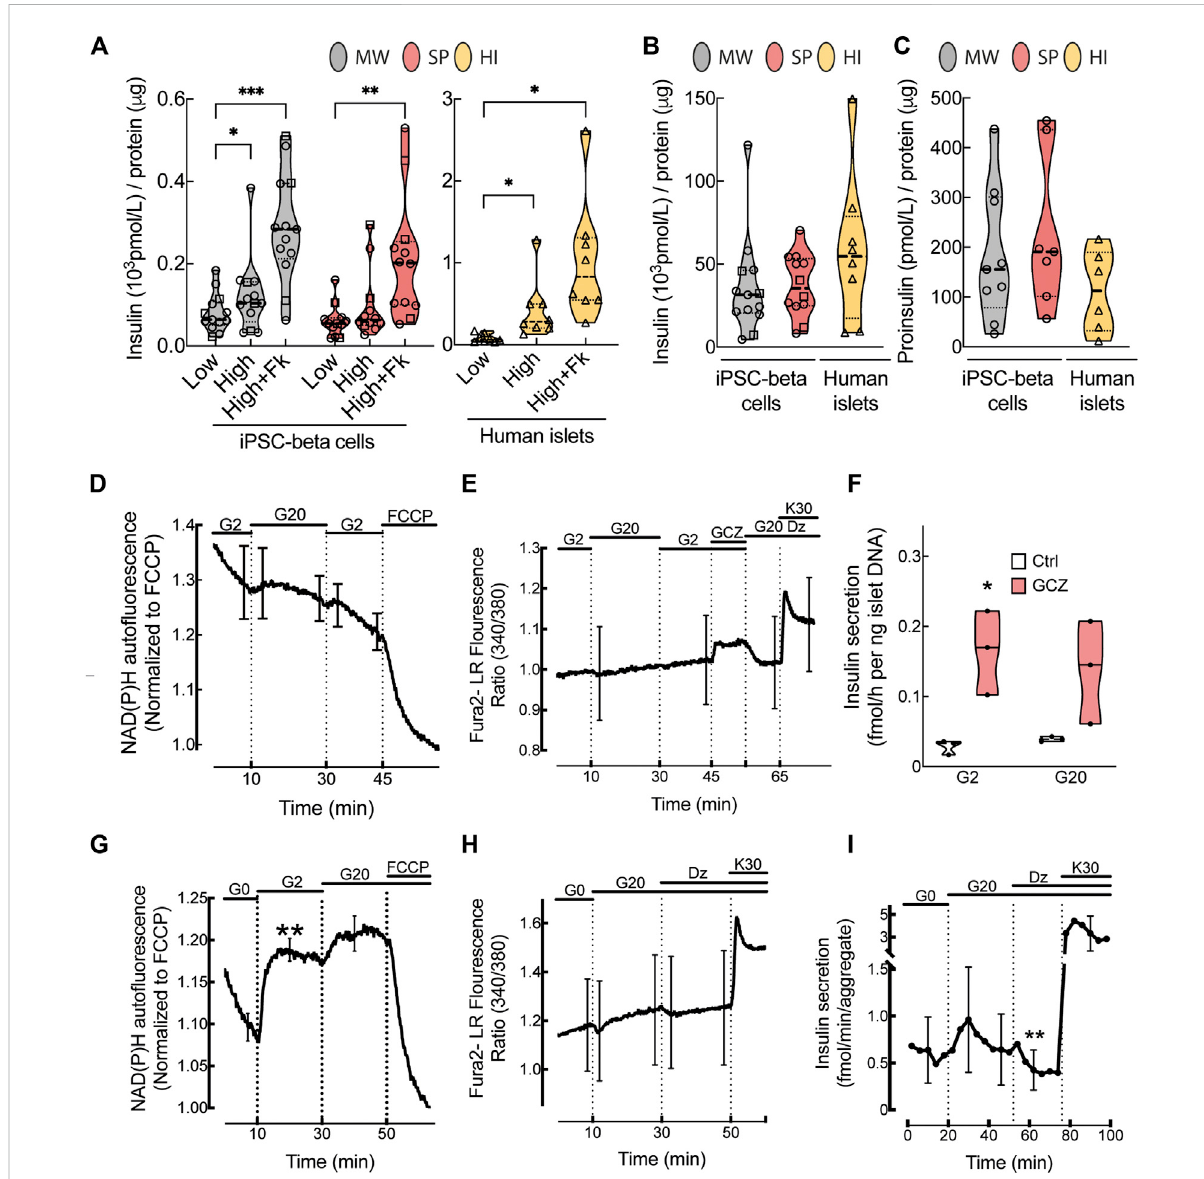
FIGURE 3 In vitro function of human iPSC-derived beta cells. (A) , Glucose-stimulated insulin release, (B) , insulin content (pmol/L) normalized by total protein ( μ g) and (C) , proinsulin content (pmol/L) normalized by the total protein ( μ g) from microwell (MW, grey bars) or suspension aggregates (SP, redbars)orhumanislets(HI,yellowbars).Tostimulateinsulinsecretion,aggregateswereexposedtolow(1.6 mmol/L)orhigh(16.7 mmol/L)glucose orhighglucoseplusforskolin(1 μ mol/L)(MWn=13;SPn=12;HIn=6 – 8). (D) ,NAD(P)Hauto fl uorescenceduringperifusionofMWaggregates at glucose concentrations (Gn, n mmol/L), as indicated on top of the fi gure (n = 6). (E) , Fura-2 LR fl uorescence ratio during perifusion of MW aggregates with KRBcontaining Gnand addedcompounds(Dz, 250 μ mol/Ldiazoxide; GCZ, 25 μ mol/L gliclazide; K30, 30 mmol/L extracellularK + ). Data are means ± SEM for 7 preparations, each with 1-2 aggregates of each kind. (F) , Insulin secretion in response to G2 or G20 with or without 25 μ mol/L GCZ (n = 3). (G,H) , Glucose-inducedchanges in NAD(P)H auto fl uorescence and fura-2 LR fl uorescence ratio after 2-h glucosestarvation (n = 5 – 6). (I) , Insulin secretion by glucose-starved MW aggregates during perifusion with Krebs containing G0, G20, Dz or K30 as indicated (n = 4). (A – C) , Median (bold dotted line) and quartiles (light dotted line) are shown; dots represent independent iPSC-beta differentiations, and symbols different cell models (Hel115.6, circles; 1023A, squares; human islets, triangles). N, number of independent experiments, de fi ned as one iPSC-beta cell differentiation or one human islet preparation, as indicated. Mixed-effects analysis followed by Bonferroni correction for multiple comparisons, * p < 0.05, ** p < 0.01, *** p < 0.005 or exact p value